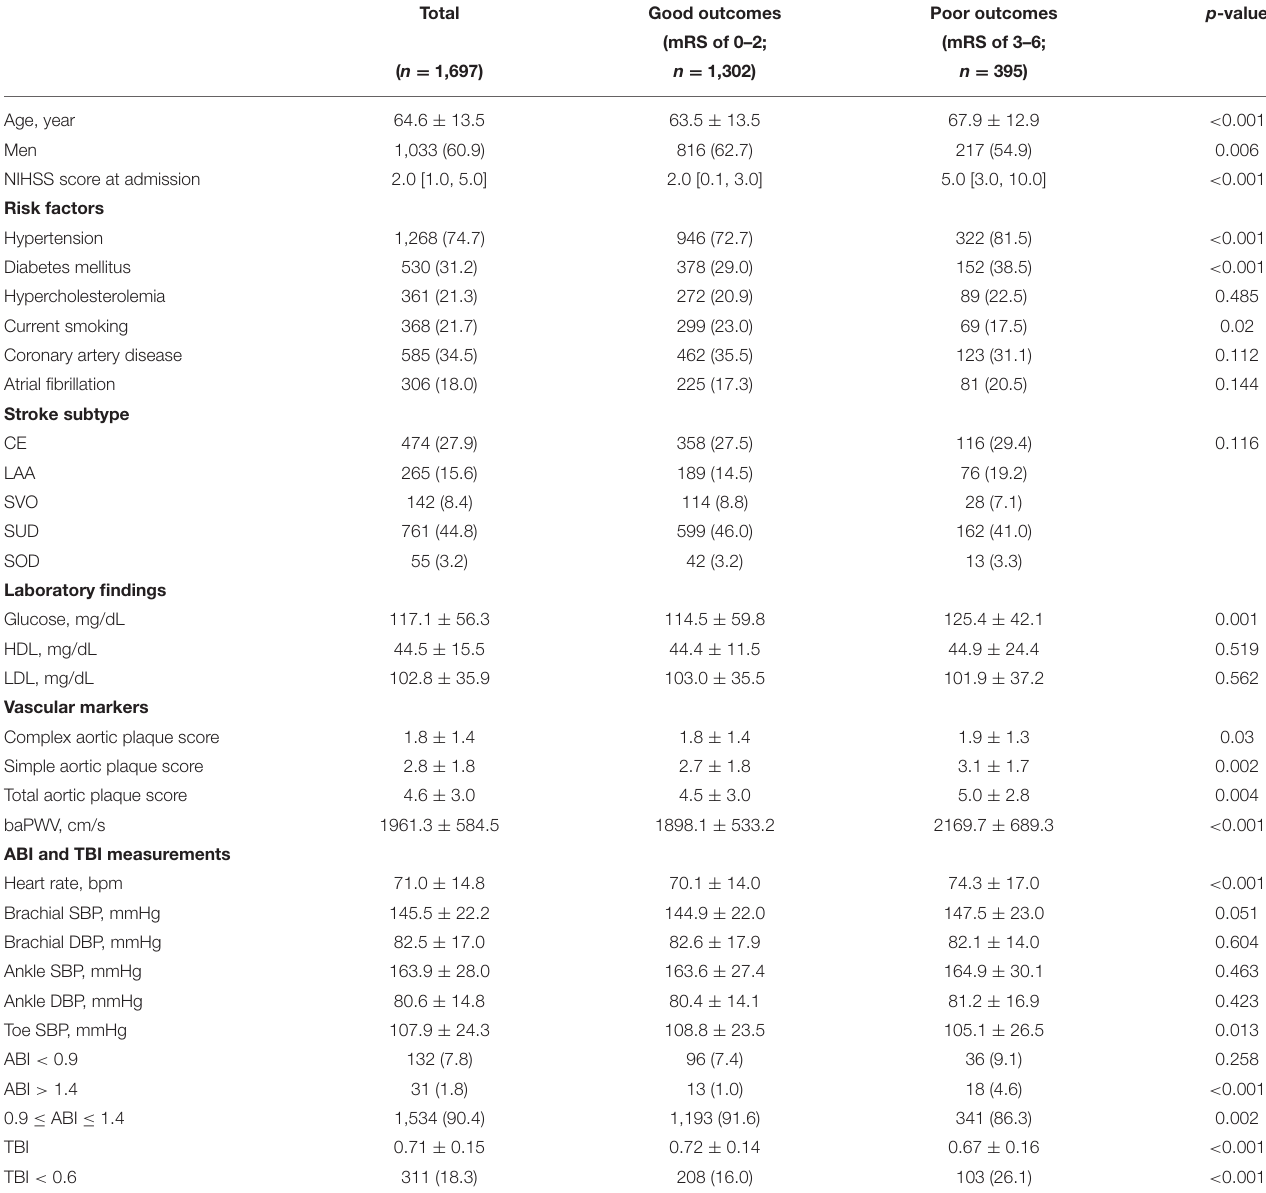
TABLE 1 | Patient demographic and clinical characteristics. Total Good outcomes Poor outcomes